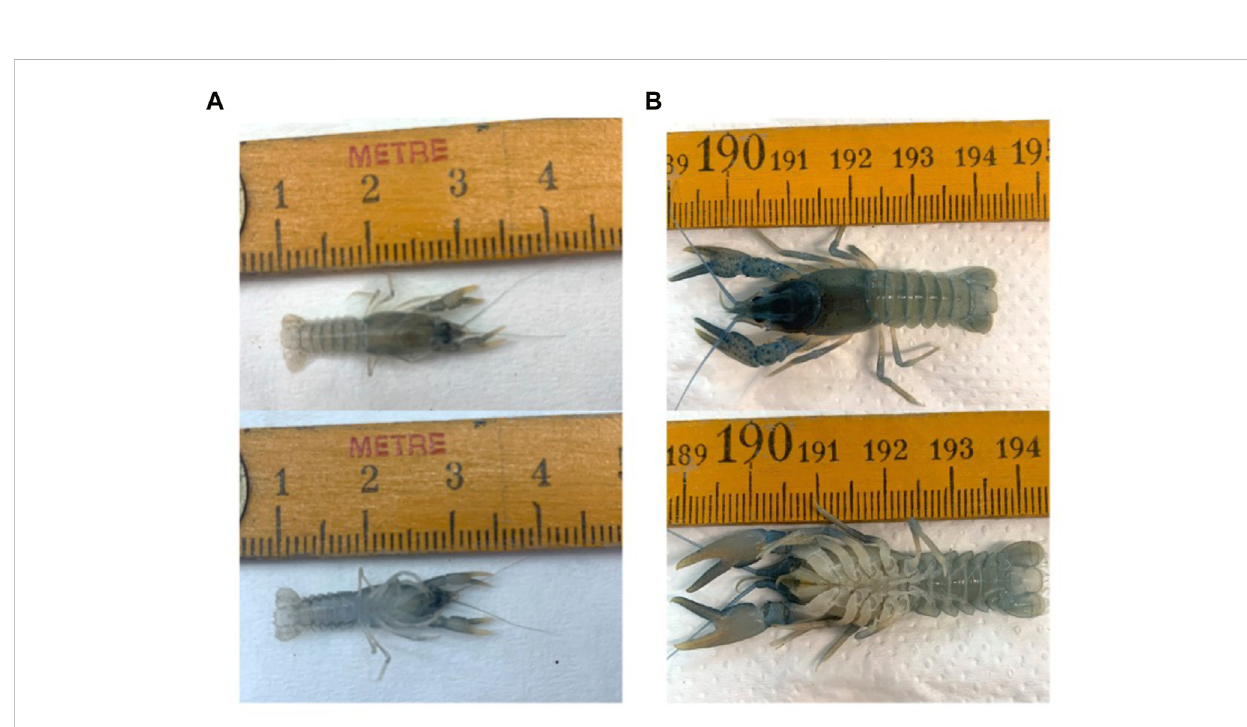
FIGURE 3 P. leptodactylus before (A) and after (B) the 98-days feeding